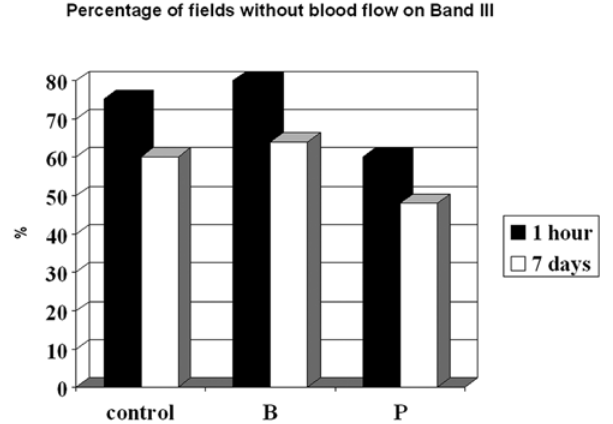
Figure 6 - Prediction by OPS imaging of the percentage of fields without blood flow after 1 h that persisted 7 days